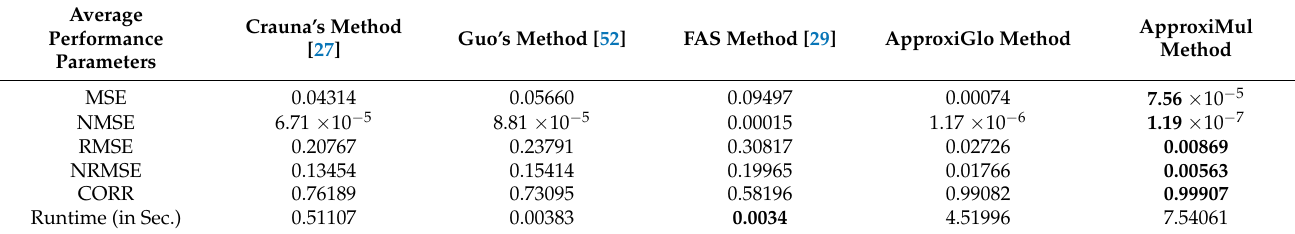
Table 6. Average results of different optimization methods used to fit normal ECG